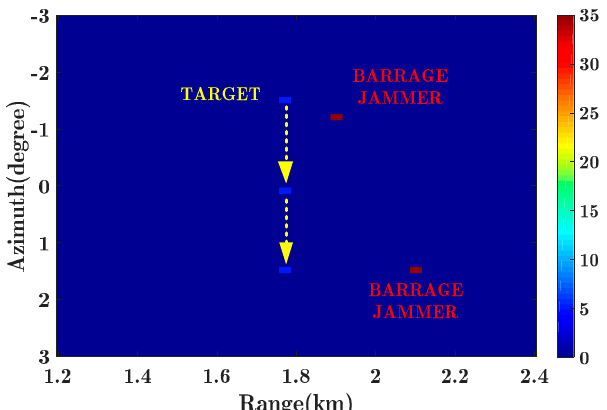
Figure 10. The jamming environment.